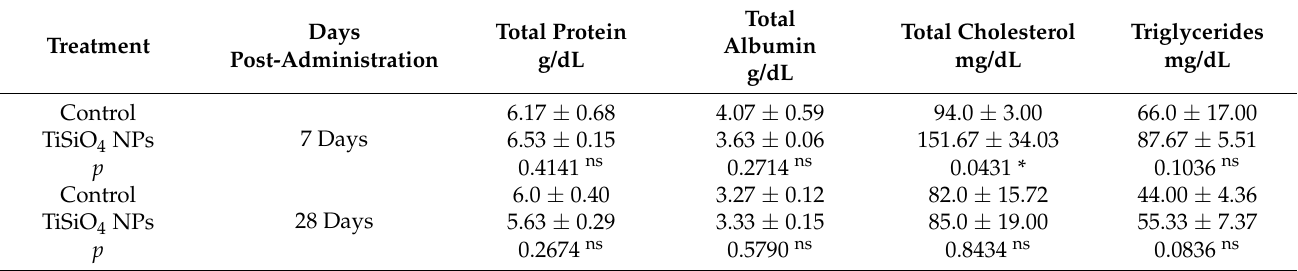
Table 1. Serum total protein, albumin, total cholesterol, and triglycerides content in male rats exposed orally to 250 mg ≤ 50 nm TiSiO 4 NPs/kg b.